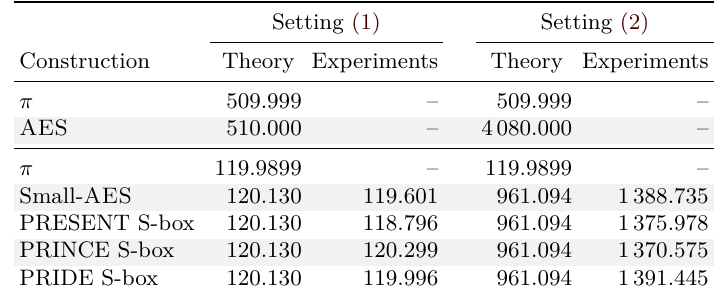
Table 8: Summary of the variances for our five-round distinguisher. π = random permutation. Exp. = experiments from 100 000 random keys with 2 14 δ -sets